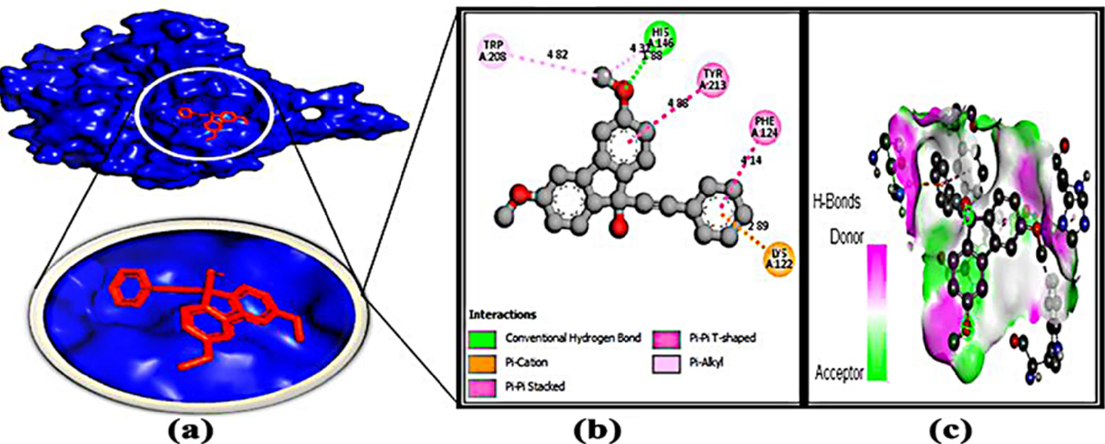
Figure 6. Docking simulation between protein–ligand interactions of nucleosidase (MTAN) enzymes and fluoren-9-ol, 3,6-dimethoxy-9-(2-phenylethynyl)-, respectively, with ( a ) cartoon view (binding pocket), ( b ) 2D view, and ( c ) hydrogen bonding.